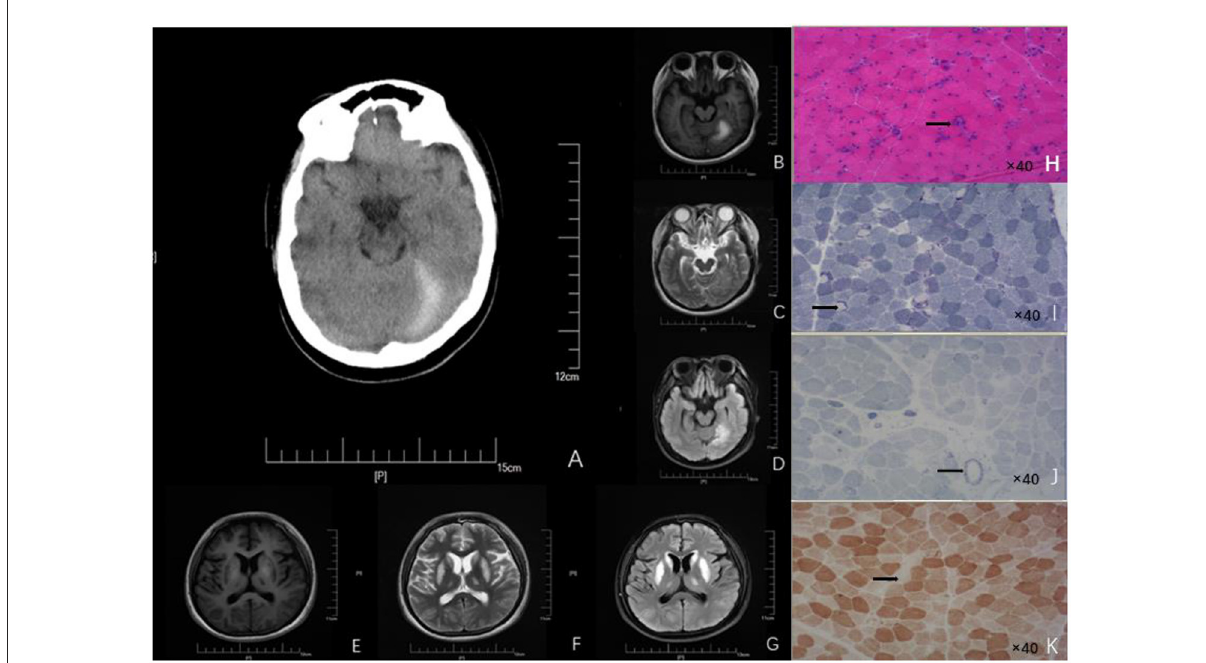
FIGURE1 Neuroimages (A–G) and skeletal muscle biopsy (H–K) of this patient. (A) Craniocerebral CT showed high-density signal on the left side of the tentorial cerebellum, indicating subdural hematoma. Patchy abnormal signals are seen on the left tentorium of the cerebellum. (B) High intensity in T1 scan. (C) Slightly high intensity on T2 scan. (D) Significantly - high intensity on FLAIR scan). Symmetrical patchy abnormal signals could be found in bilateral lentiform nucleus, caudate nucleus head, and ventrolateral nucleus. (E) Low signal intensity in T1 scans. (F) Slight-higher signal intensity in T2 scans. (G) Obvious-high signal intensity in FLAIR scans. (H) HE findings of the skeletal muscle biopsy (right biceps muscle) revealed that the diameter of muscle fibers varied greatly; Atrophic muscle fibers were scattered in round and small circles together with large number of necrotic and regenerated muscle fibers (black arrow; 40 × magnification). (I) NADH staining revealed uneven enzyme activity in some muscle fibers and dense staining around the muscle fibers (black arrow, 40 × magnification). (J) SDH staining revealed SSV and several black arrow (black arrow; 40 × magnification). (K) COX staining revealed negative-stained muscle fibers (black arrow; 40 × magnification). HE, Hematoxylin-eosin; NADH, Nicotinamide adenine dinucleotide; CT, Computed tomography; FLAIR, Fluid attenuated inversion